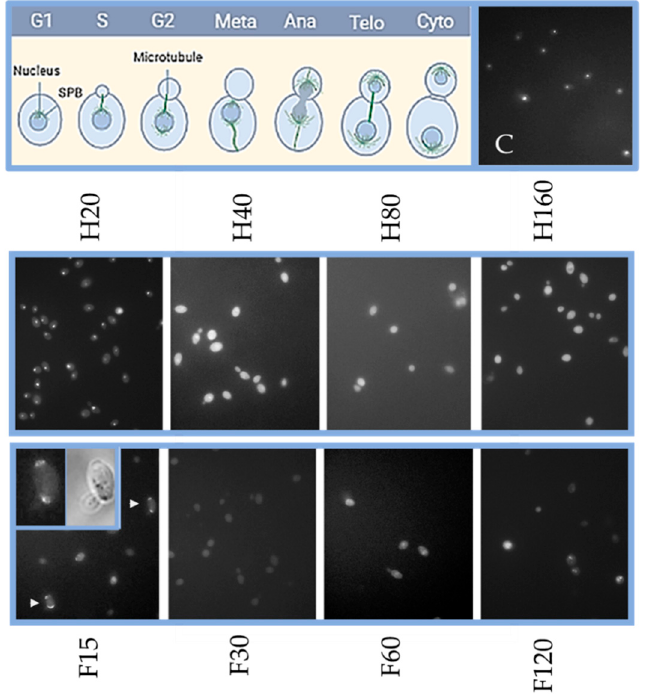
Figure 2. Dose-dependent effects on cell cycle by photosensitizers. Representative images from asynchronous log-phase cells grown for 3 h in the absence (C) or presence of fagopyrin (F) and hypericin (H). A schematic figure depicting the landmark events of the normal cell cycle progression (top left panel). Cells were stained with the fluorescent stain DAPI to visualize nuclei. DAPI staining revealed that exposure to photosensitizers caused diffuse DAPI signal in a dose-dependent manner. Arrowheads (white) show cells that underwent precocious mitosis in the absence of bud. A more detailed view of nuclei and cell morphology (bright field) is in the insets.